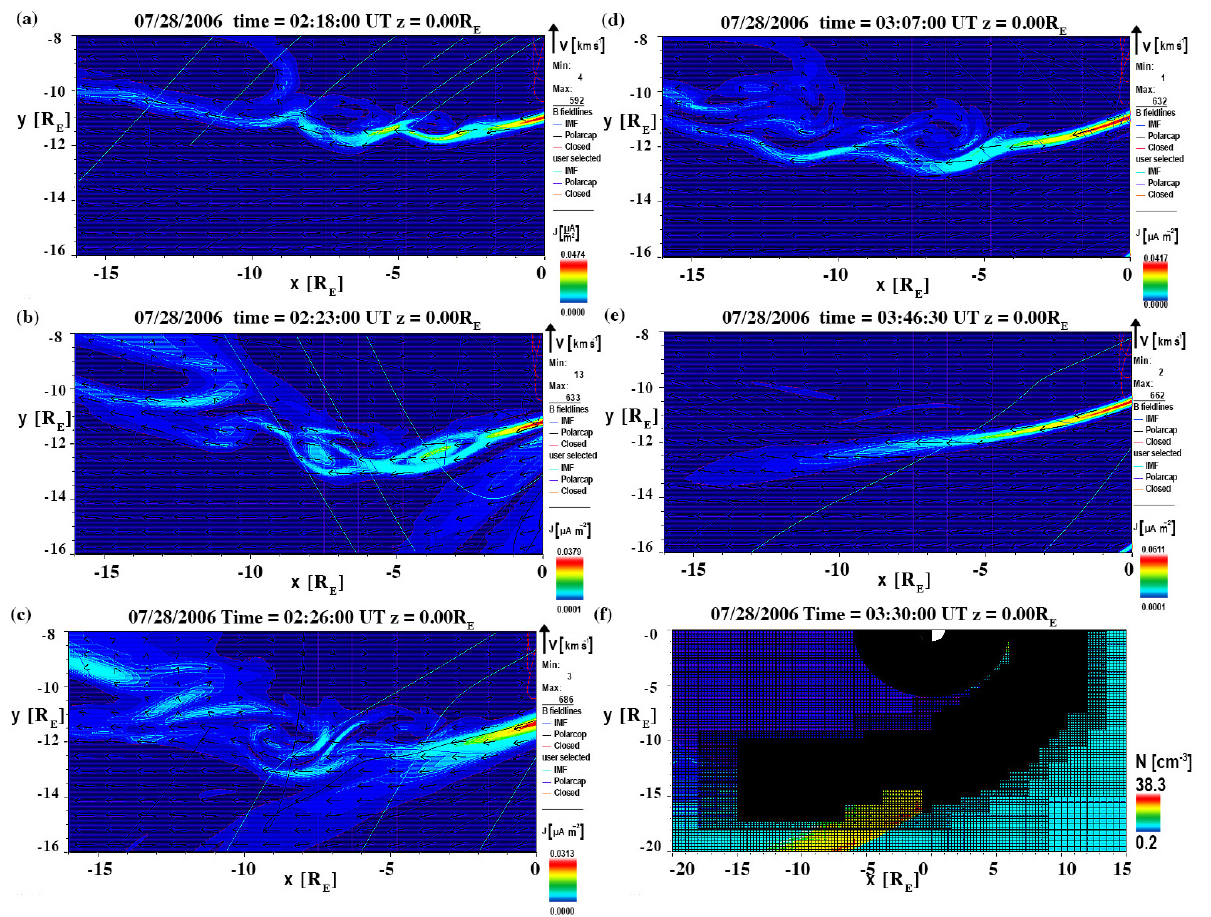
Figure 2. Figure from Hwang et al. (2011) where vortices were found using the BATS-R-US simulation. The region of the dawnside flank magnetopause is blown up ( − 16 ≤ X(R E ) ≤ 0 and − 16 ≤ Y(R E ) ≤ − 8), the current density is color-coded, and flow velocities are denoted by arrows (a–e) . The grid in the X – Y plane used for the simulation is shown in panel (f) where density is color-coded